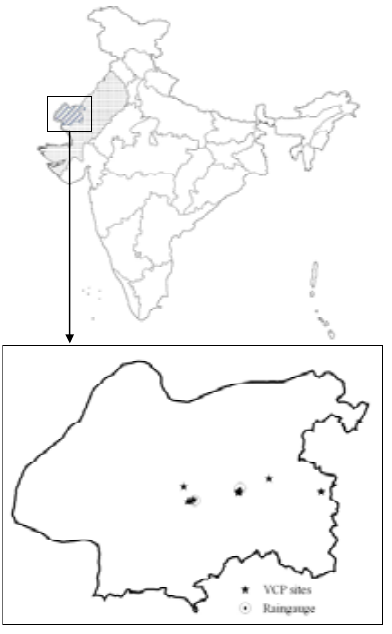
Figure 1. Location of study area in the Indian Thar desert and observation points in Jaisalmer district